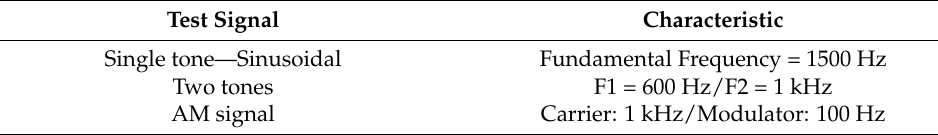
Table 3. Signals used for validation of the acquisition system.